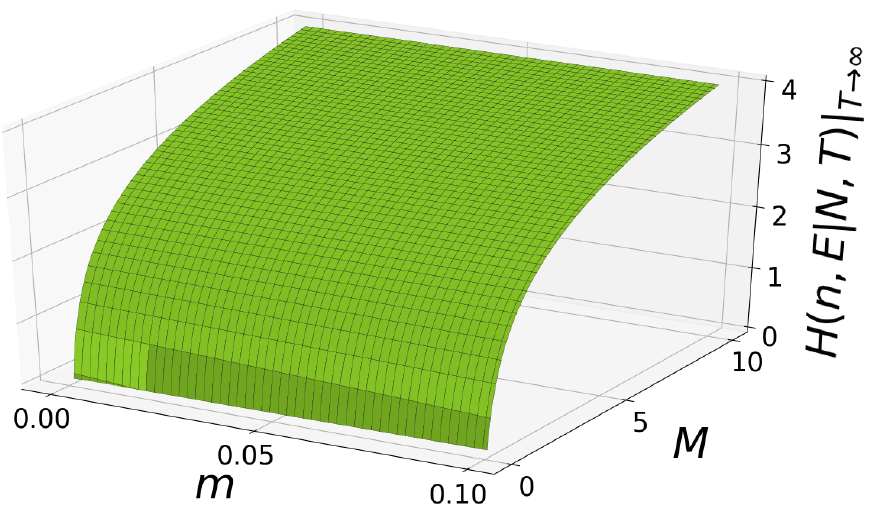
Figure 4. (Color online) High-temperature asymptotics of the entropy H ( n , E | N , T ) of Unruh radia- tion given by Equation (28) for fermions ( N = 2 ) as a function of m and M